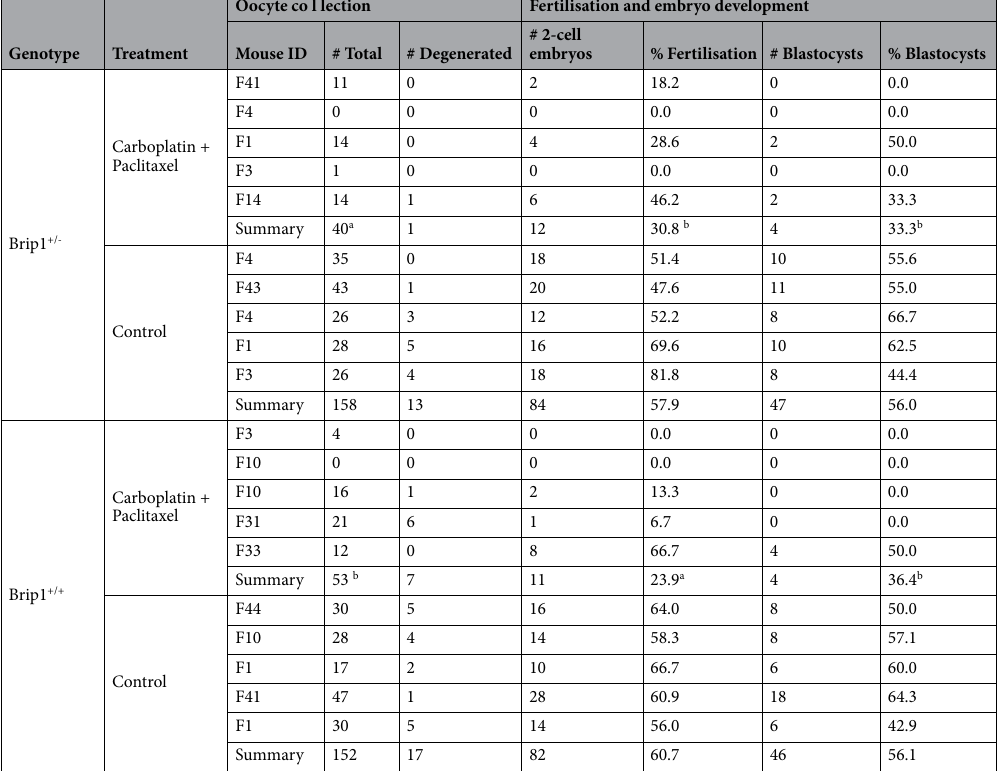
Table 1. In vitro fertilisation experiments. Oocyte recovery, fertilisation rate and embryo developmental competence in Brip1 + /− and Brip1 + / + mice treated with the combination of carboplatin and paclitaxel or with NaCl 0.9% (control group), three weeks after the completion of the treatment. n = 5/treatment/genotype. a p < 0.01, b p <